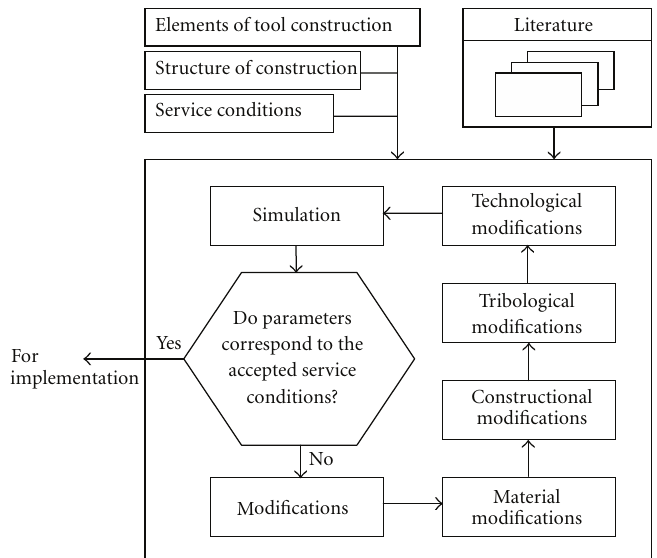
Figure 1: Procedures for designing modernized grinding tools with specified types of modifications.